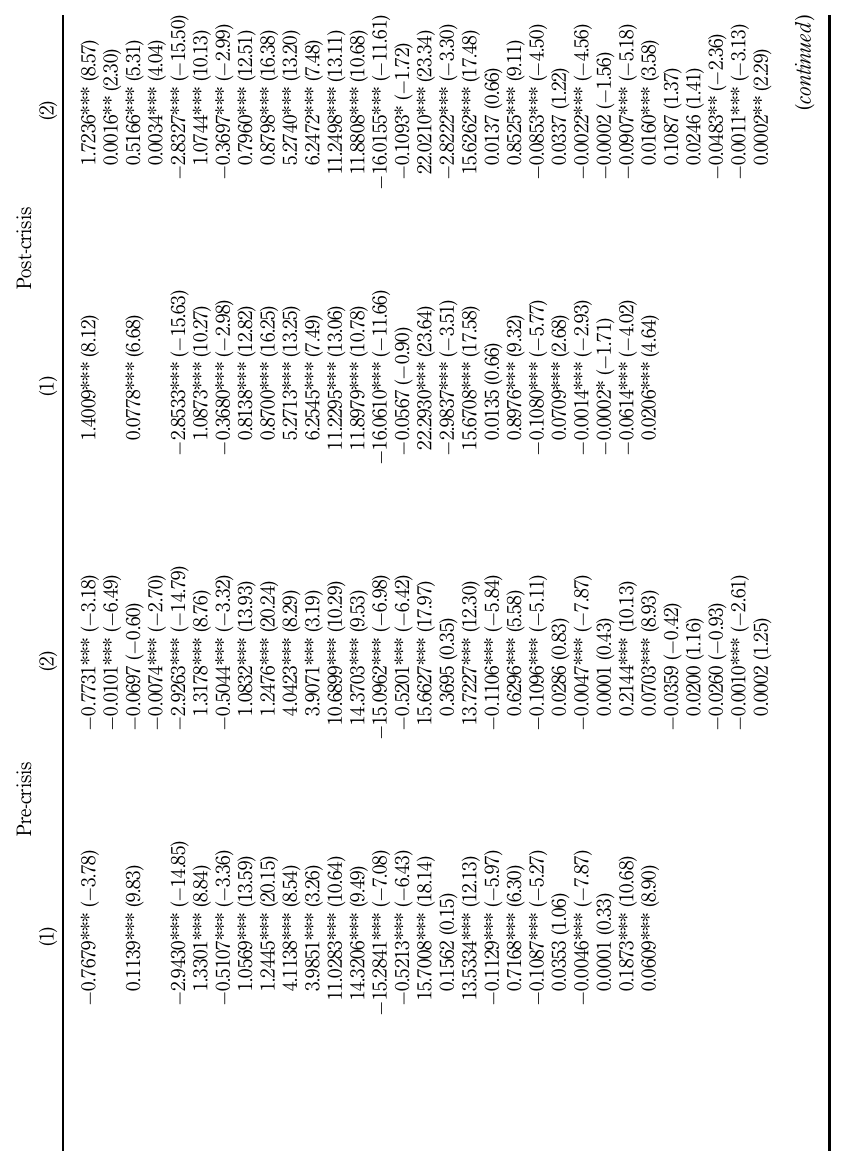
Table 2. Economic policy uncertainty and value of cash during the pre- crisis and the post- crisis